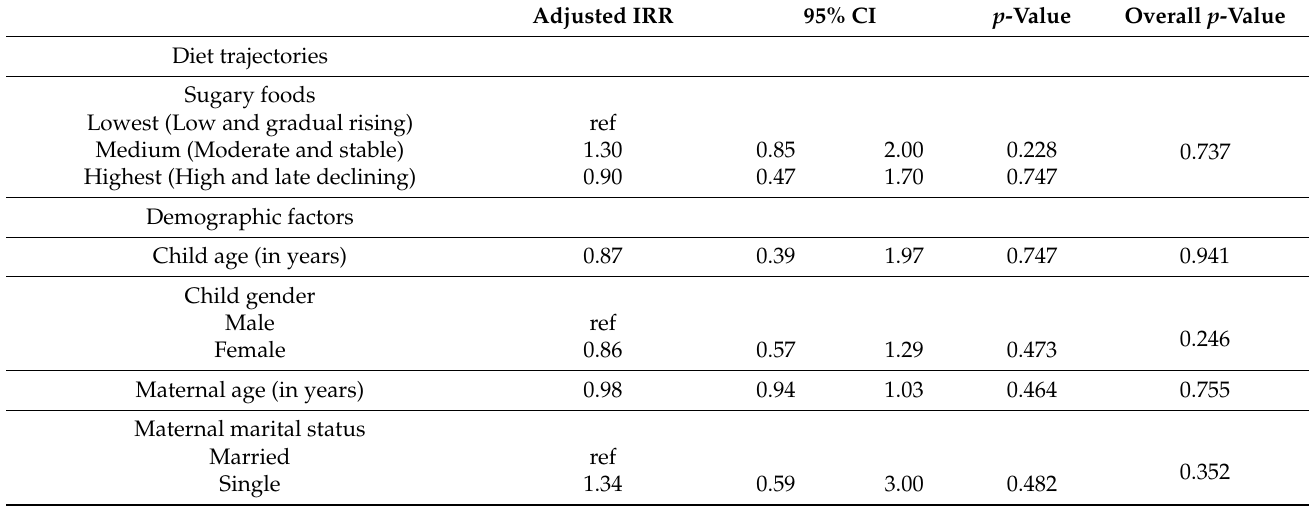
Table 4. Final model—impact of diet trajectories, demographic, socioeconomic, and behavioural factors on early child- hood